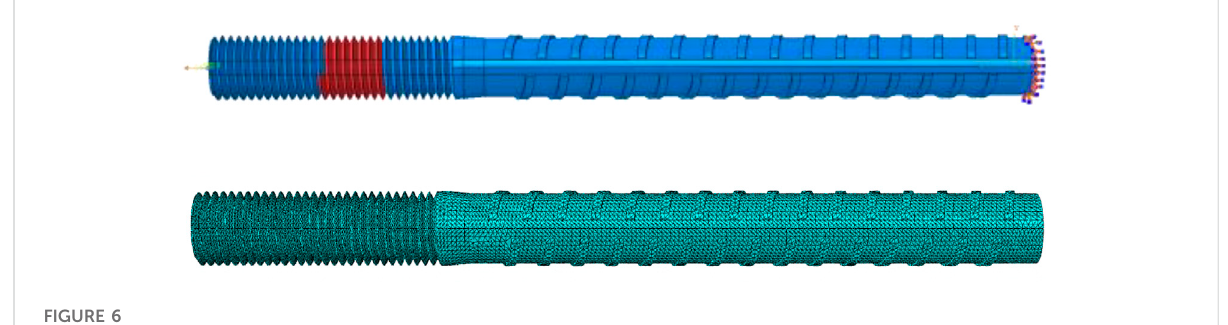
FIGURE 6 Model and mesh generation.